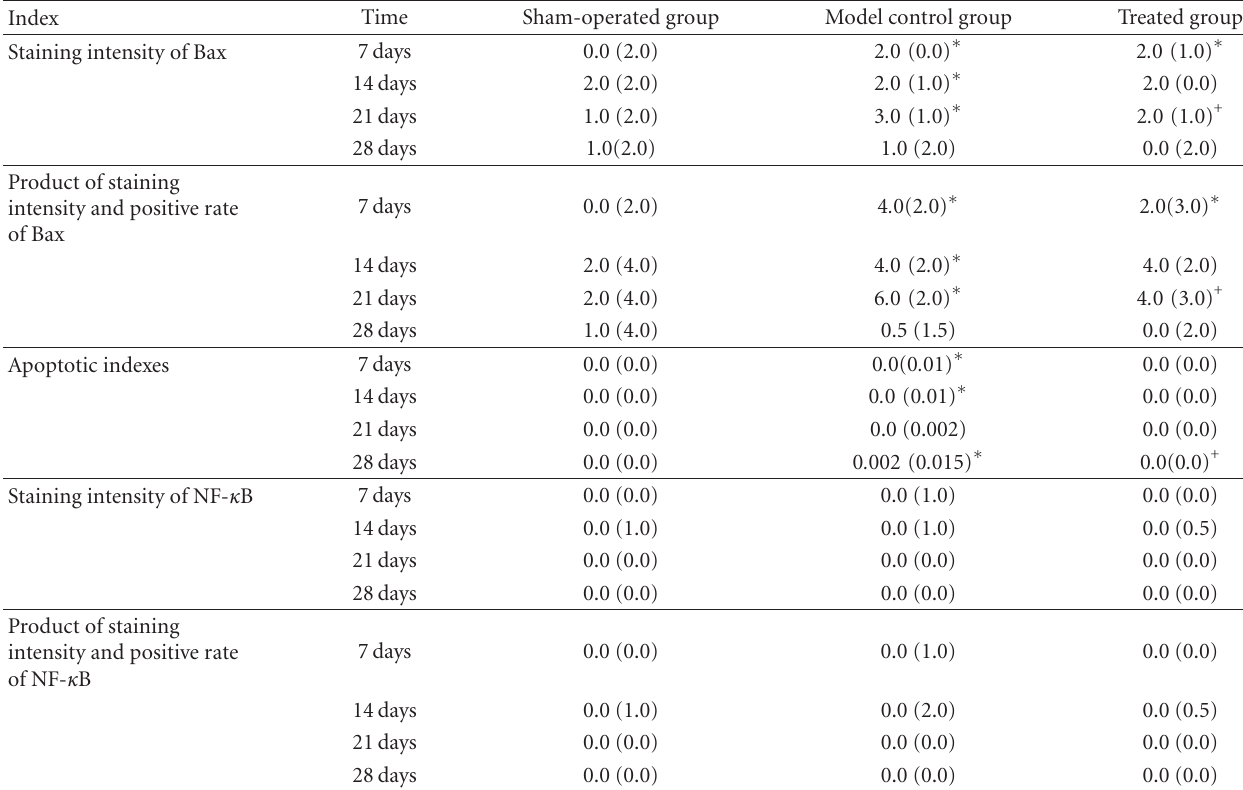
Table 7: Comparison of pathological indexes of spleen in OJ groups ( M ( Q R